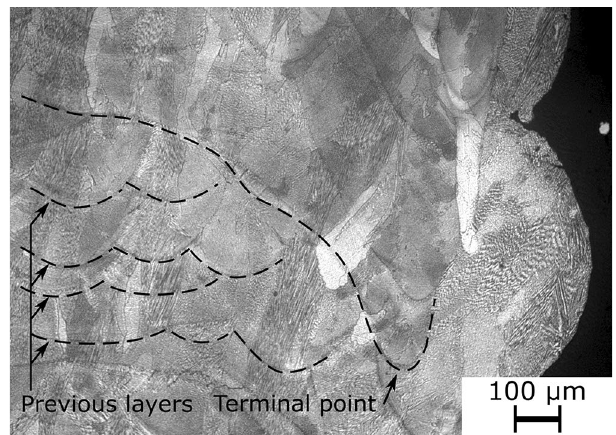
Figure 6. Specimen’s microstructure at the edge (laser turning